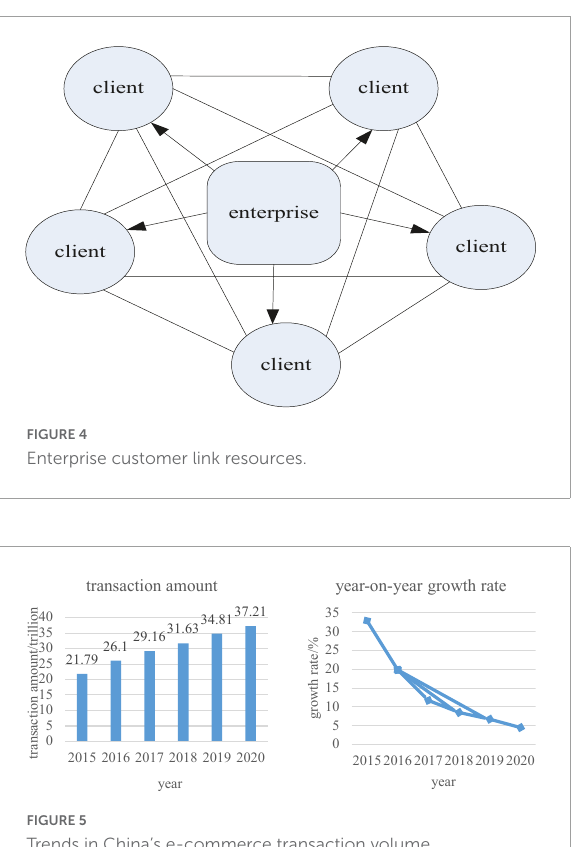
FIGURE5 Trends in China’s e-commerce transaction volume.